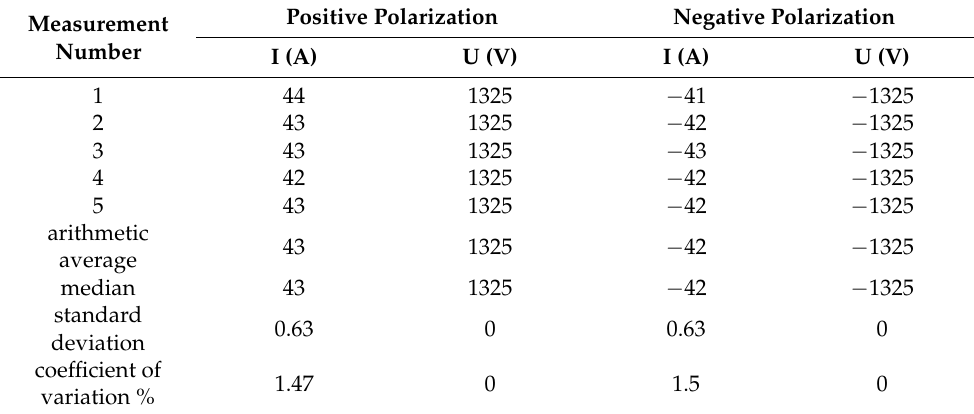
Table 5. The immunity test results of photovoltaic microinstallation disturbed by a 1.2/50 µ s voltage